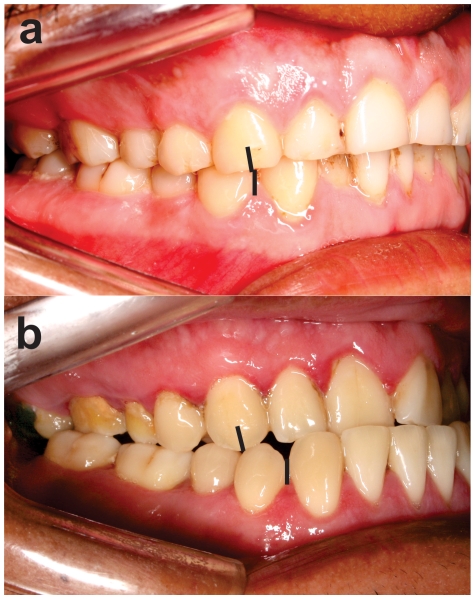
Dental occlusion in a split Amazon indigenous population.
A) Normal occlusion as observed in a male individual from the Arara-Laranjal village. The lines indicate the upper canine tip occluding between the lower canine and lower 1st premolar. B) Class III malocclusion associated with anterior and posterior crossbite in a male from the Arara-Iriri village. The lines indicate a misaligned upper canine tip occluding posterior to the lower canine and lower 1st premolar.